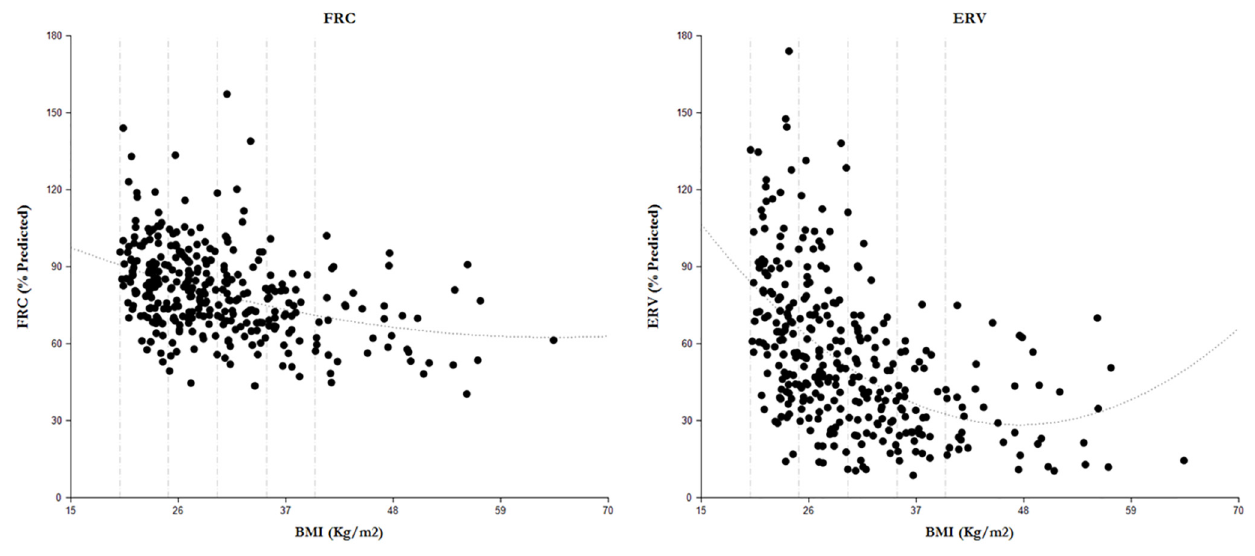
Fig 2. The polynomial regressions for FRC (left) and ERV (right). The r 2 values for FRC and ERV were 0.151 and 0.269, and the second order polynomial regression equations were as follows: FRC = 0.0143 * (BMI) 2 – 1.8448 * (BMI) + 121.88 and ERV = 0.0742 * (BMI) 2 – 7.0384 * (BMI) + 195.29 with p < 0.0001. The BMI classifications are the same as those in Fig